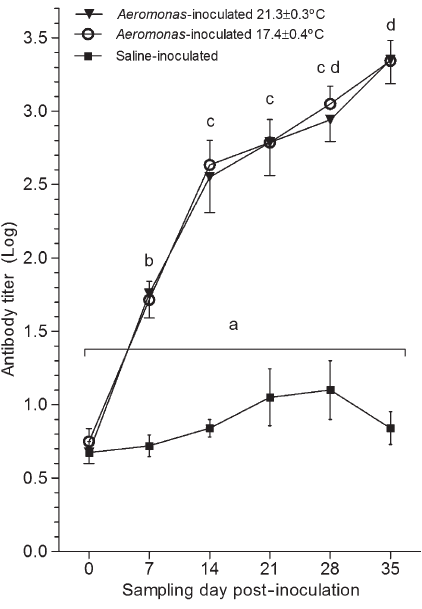
Figure 1. Kinetics of specific antibody production in silver catfish following intraperitoneal inoculation with inactivated Aeromonas hydrophila or sterile saline and kept at different water tempera- tures. Serum samples were collected prior to immunization (day 0) and at 7-day intervals. The results obtained from saline- inoculated fish kept at different temperatures were similar and were combined in a single group. Data are reported as the logarithm (± SE) of the last serum dilution that caused bacterium agglutination and were compared using two-way ANOVA and the Bonferroni post-test. Significant differences (P , 0.05) are indi- cated by different letters at each time